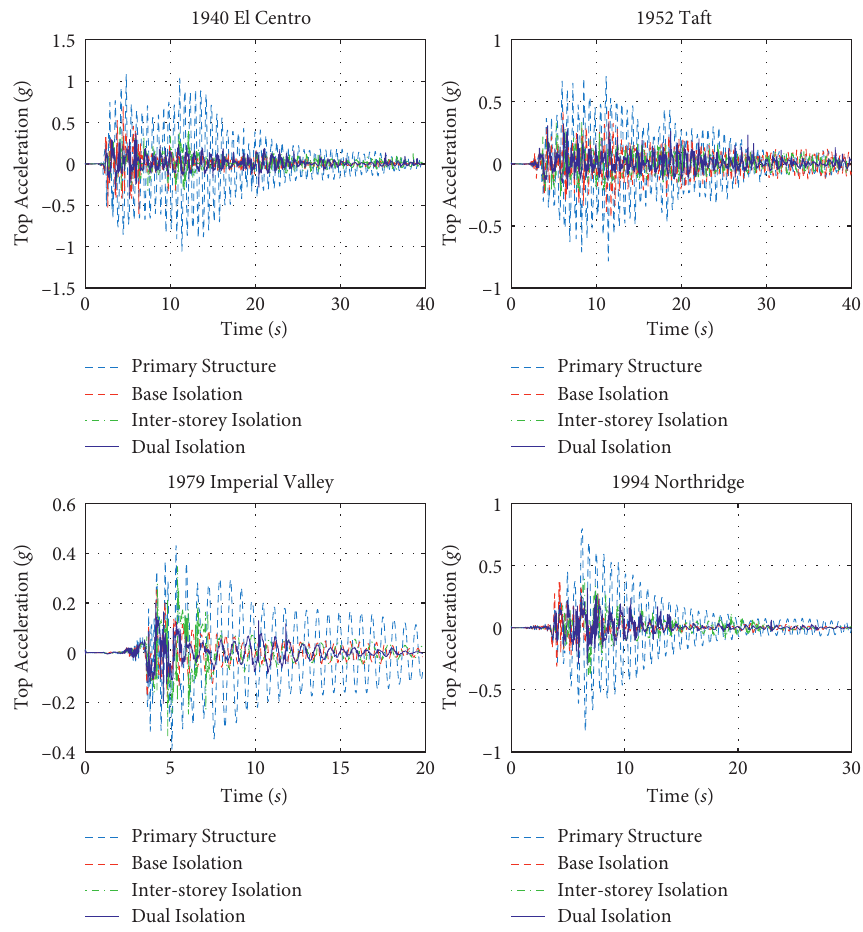
Figure 9: Top acceleration time-history curve. Table 4: Top acceleration vibration reduction rate of the structure FPS isolation system/( % ). PGA (g) 1940 El Centro